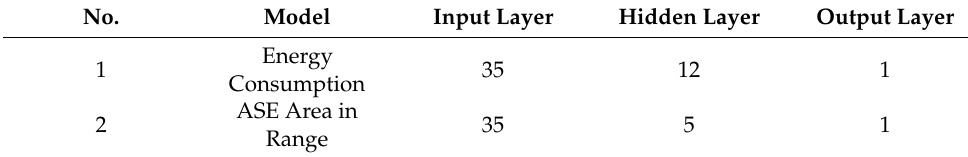
Table 5. The number of neurons in each layer. No. Model Input Layer Hidden Layer Output Layer Energy 1 Consumption ASE Area in 35 Range